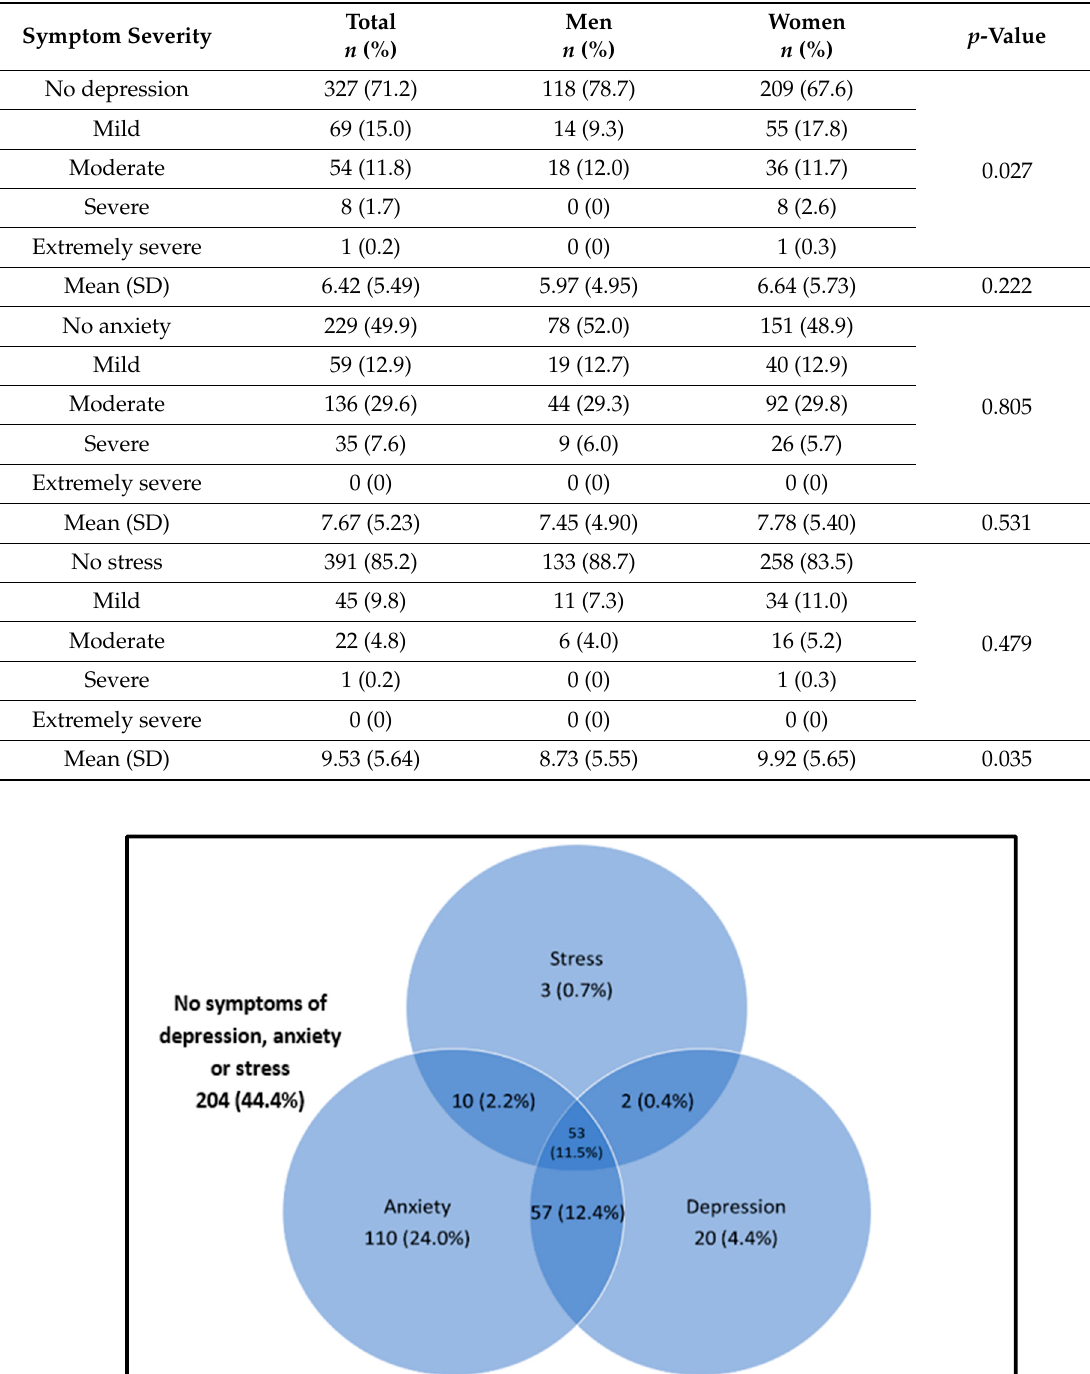
Table 2. Total scores from the DASS-21 questionnaire and by gender ( n = 459).